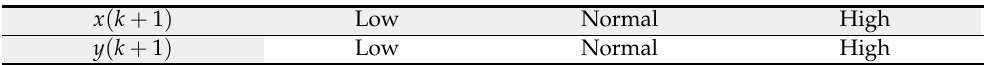
Table 3. Example of a rules table x ( k + 1 ) vs. y ( k + 1 ) (function g ). The gray cells represent the different states and responses allowed by the system.